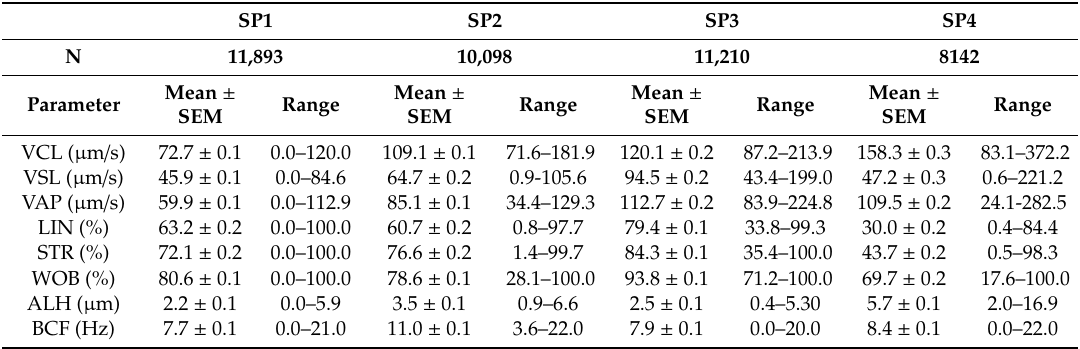
Table 2. Descriptive parameters (mean ± SEM; range) of the four sperm subpopulations (SP1, SP2, SP3, and SP4) identified in stallion fresh semen.